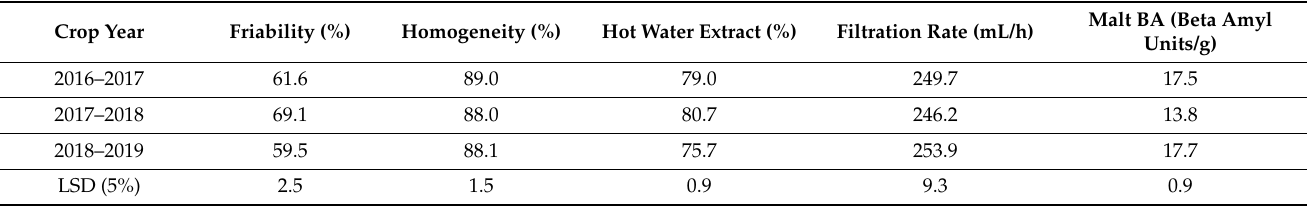
Table 4. Effect of growing year on malt quality traits.